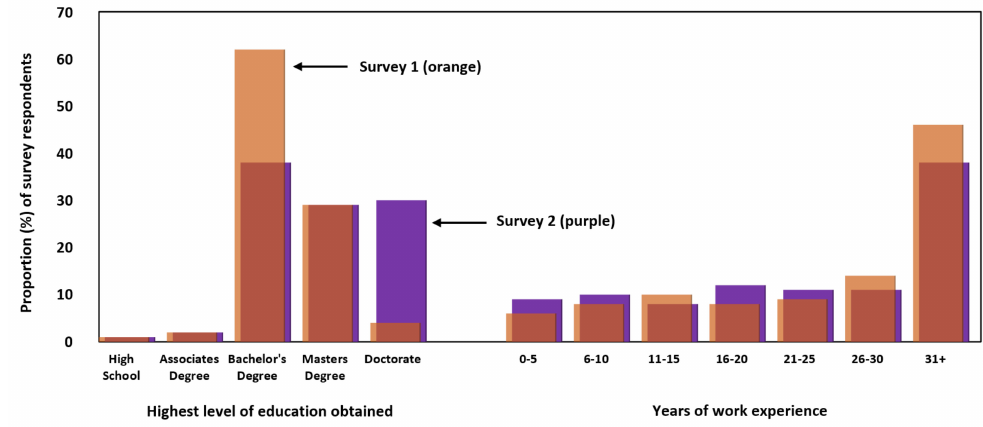
Figure 2. Profile of the respondents to the two surveys based on level of education and years of